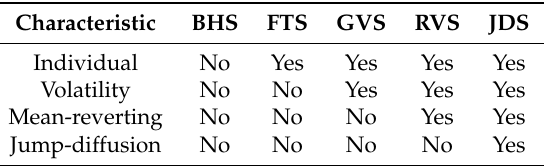
Table 2. Overview of the characteristics of the S&P 500 buy-and-hold strategy (BHS), fixed threshold strategy (FTS), generalized volatility strategy (GVS), reverting volatility strategy (RVS), and jump-diffusion strategy